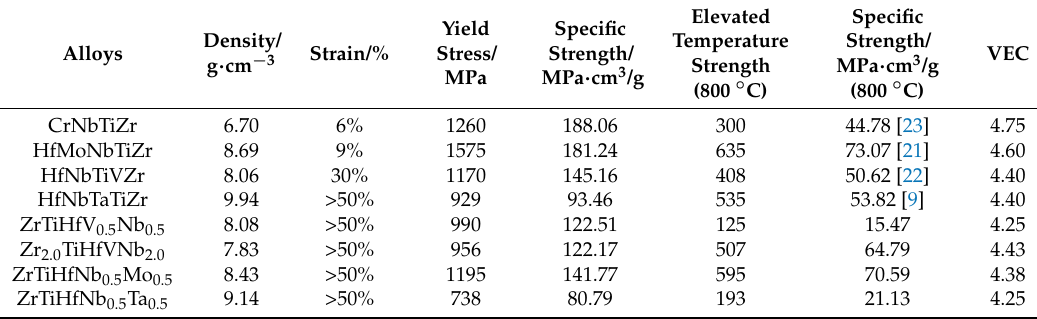
Table 3. The density and mechanical properties at room temperature (RT) and high temperature compared with referenced literature.